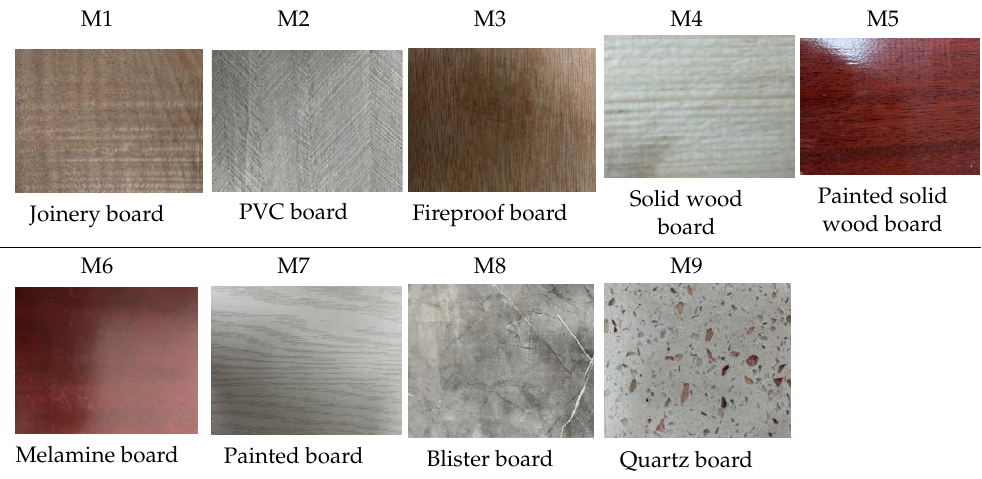
Table 1. Cabinet material samples.